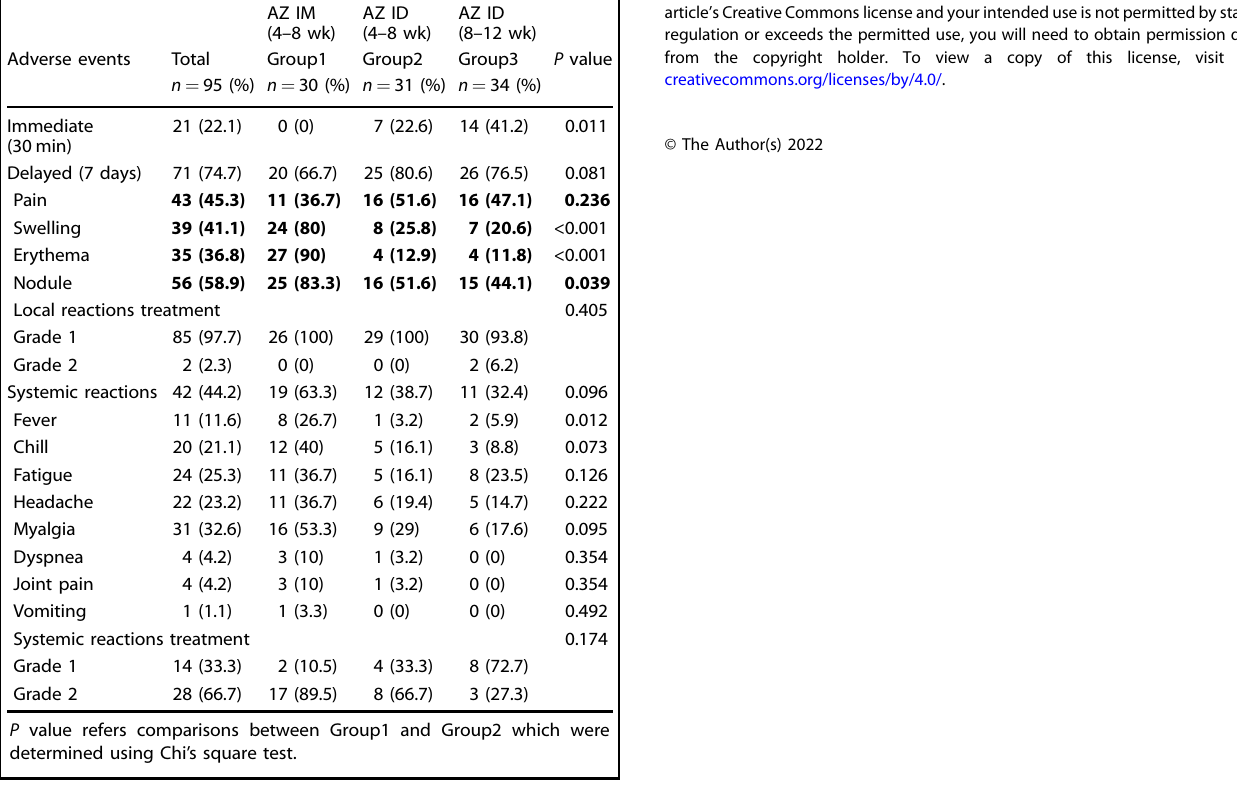
Table 2. Adverse events of the intramuscular (IM) and intradermal (ID) boosted ChAdOx1 nCoV-19 (Oxford-AstraZeneca; AZ) in the tested groups. AZ IM (4 – 8 wk)